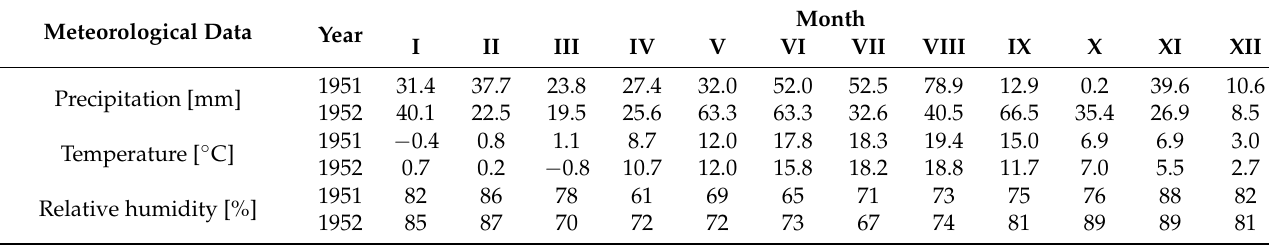
Table A3. Meteorological data (research